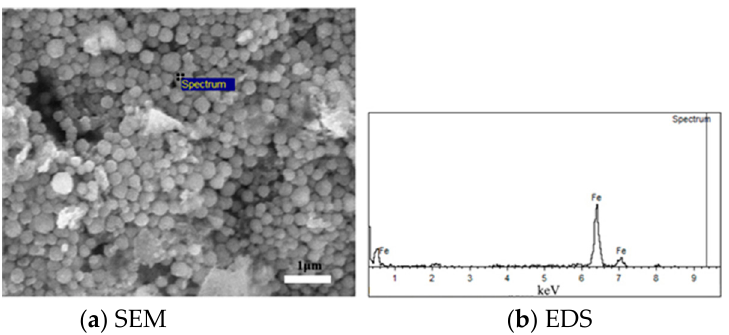
Figure 9. SEM analysis of Brazilian mineral powder under the condition of carbon powder coating.